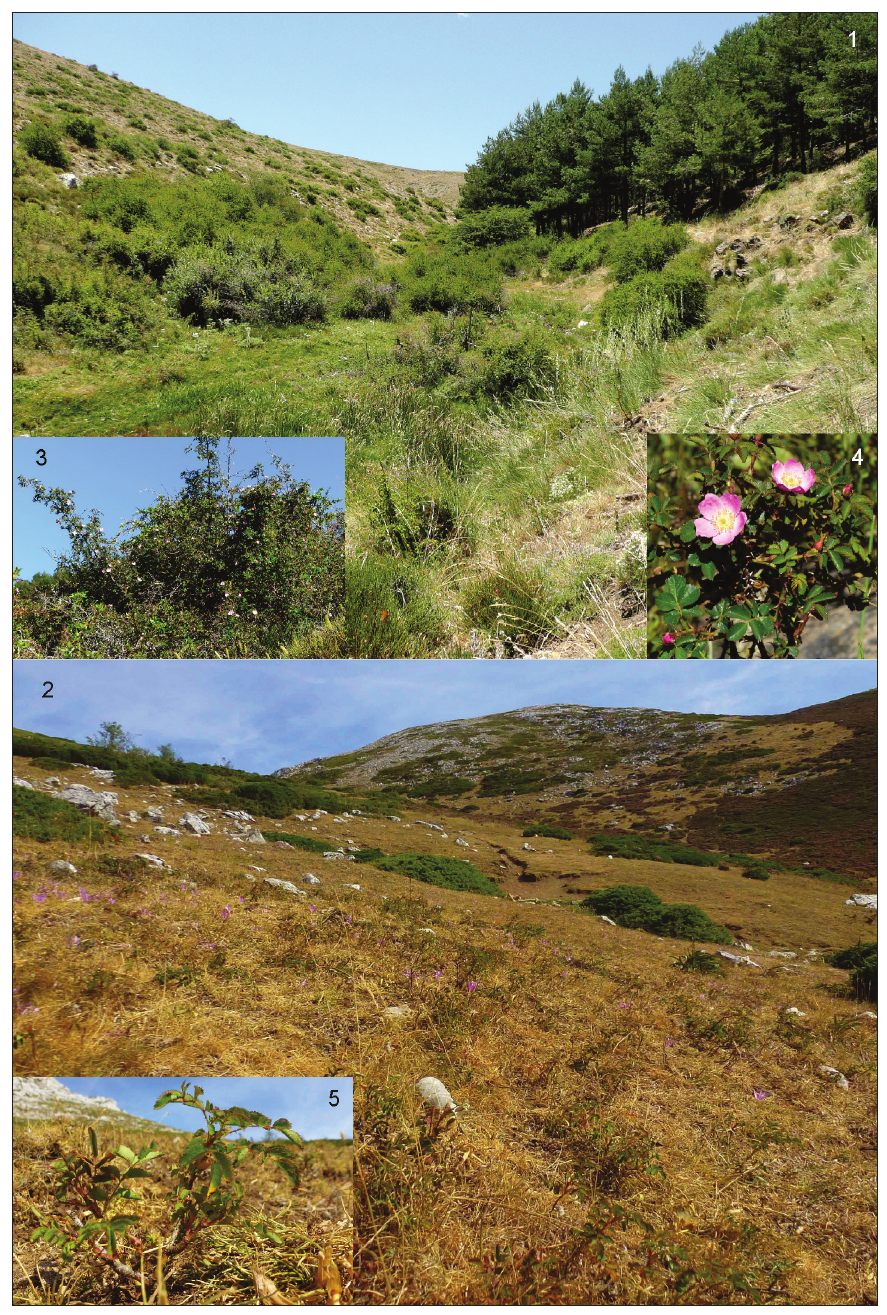
Figures 1–5. Habitats and foodplants of Spialia rosae in the Iberian Peninsula. 1. Habitat in Puerto de la Ragua, 2090 m (Sierra Nevada, Spain, July 2011). 2. Habitat in Pico Yordas, 1700 m (Cantabrian Mountains, Spain, September 2012). 3. Plant of Rosa sicula (July 2013). 4. Flowers of R. sicula (July 2013). 5. Plant of R. pendulina (September